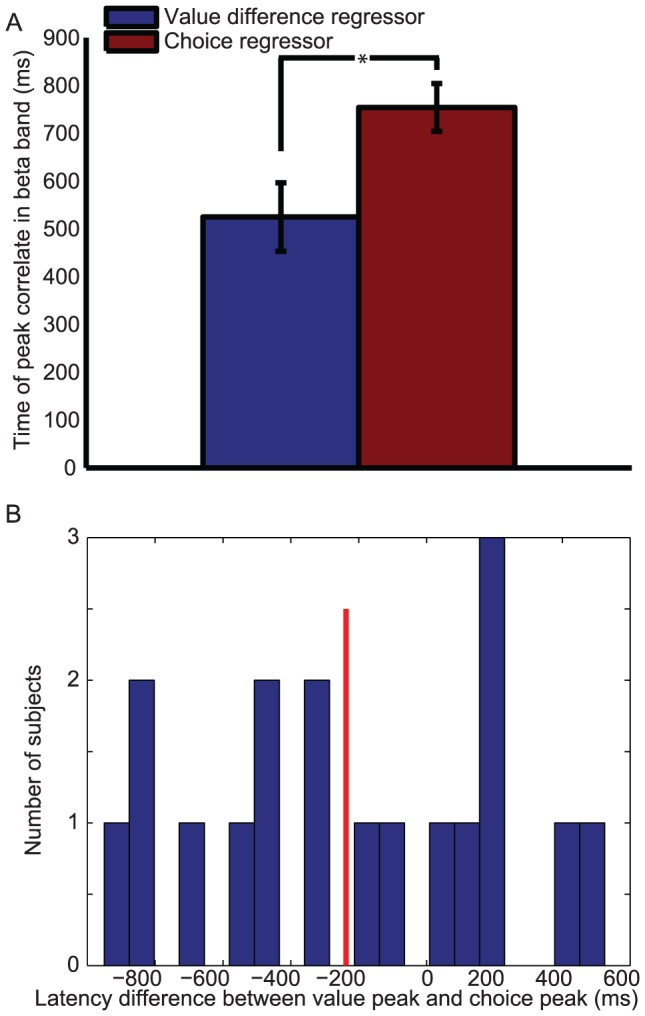
Relative latency of ‘action value difference’ and ‘choice’ effects (both in motor cortex beta desynchronisation) after stimulus 2 presentation on ‘sequential’ trials.(A) Comparison of the latency of the peak correlate of ‘value difference’ regressor in motor cortex beta desynchronisation (blue) against the latency of the peak correlate of the ‘categorical choice’ regressor in motor cortex beta desynchronisation (red). * denotes p<0.05, paired T-test across 18 subjects. (B) Histogram of individual subjects' latency differences between ‘value difference’ peak latency and ‘categorical choice’ peak latency; red line denotes median latency across subjects.